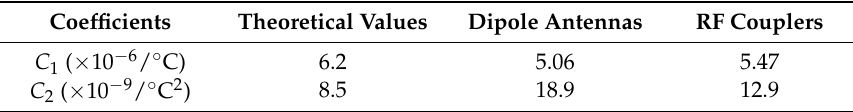
Table 3. Coefficients C 1 and C 2 obtained with dipole antennas and RF couplers. The theoretical values, obtained by replacing the coefficients taken from the sensor datasheet in Equation (4), are included for